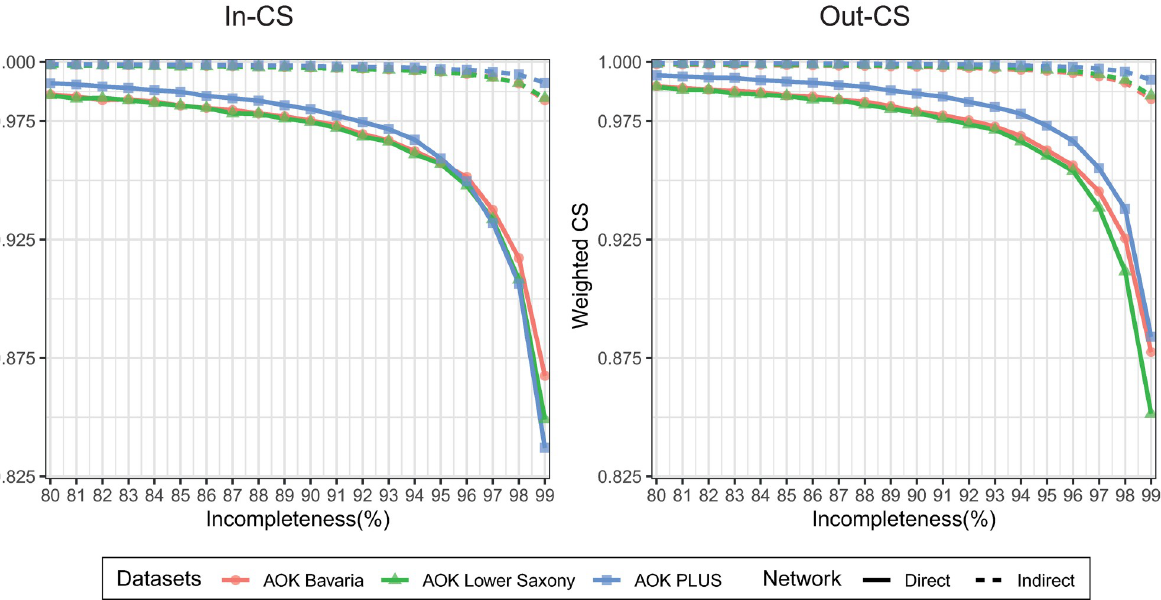
Fig 3. Weighted cosine similarities (CSs). Weighted CSs in directions “in” and “out” between the sampled networks and the whole hospital networks as a function of the incompleteness levels for three insurance datasets. The solid and dashed lines represented the weighted CSs on direct and indirect hospital networks based on these AOK datasets,